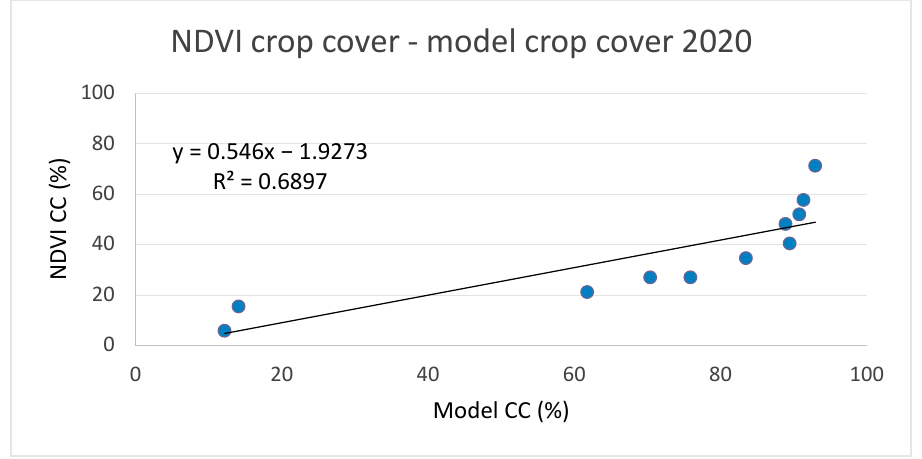
Figure 5. Comparison between NDVI biomass and modeled biomass for winter wheat in 2021.